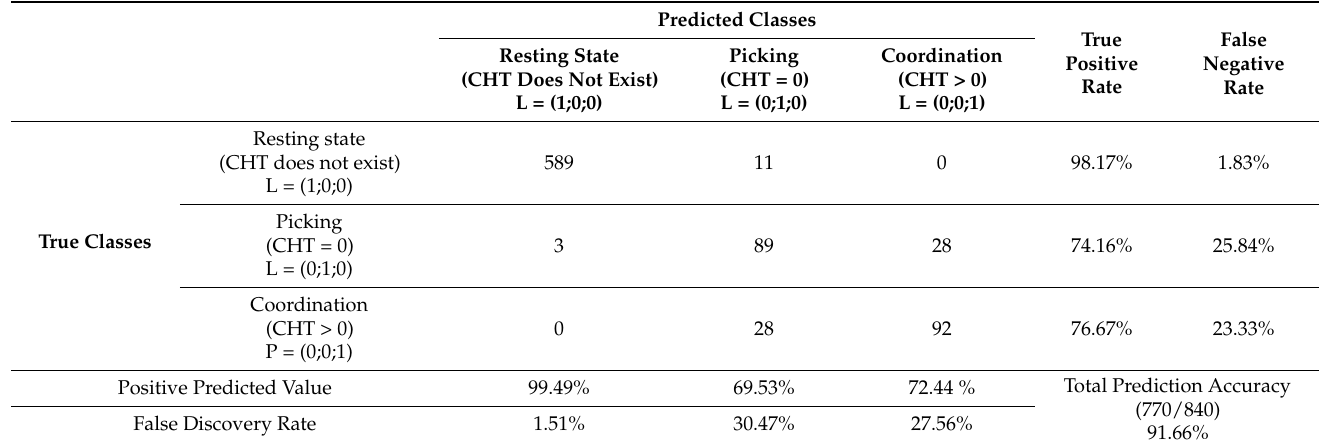
Table 3. Optimal model using multiple channels—confusion